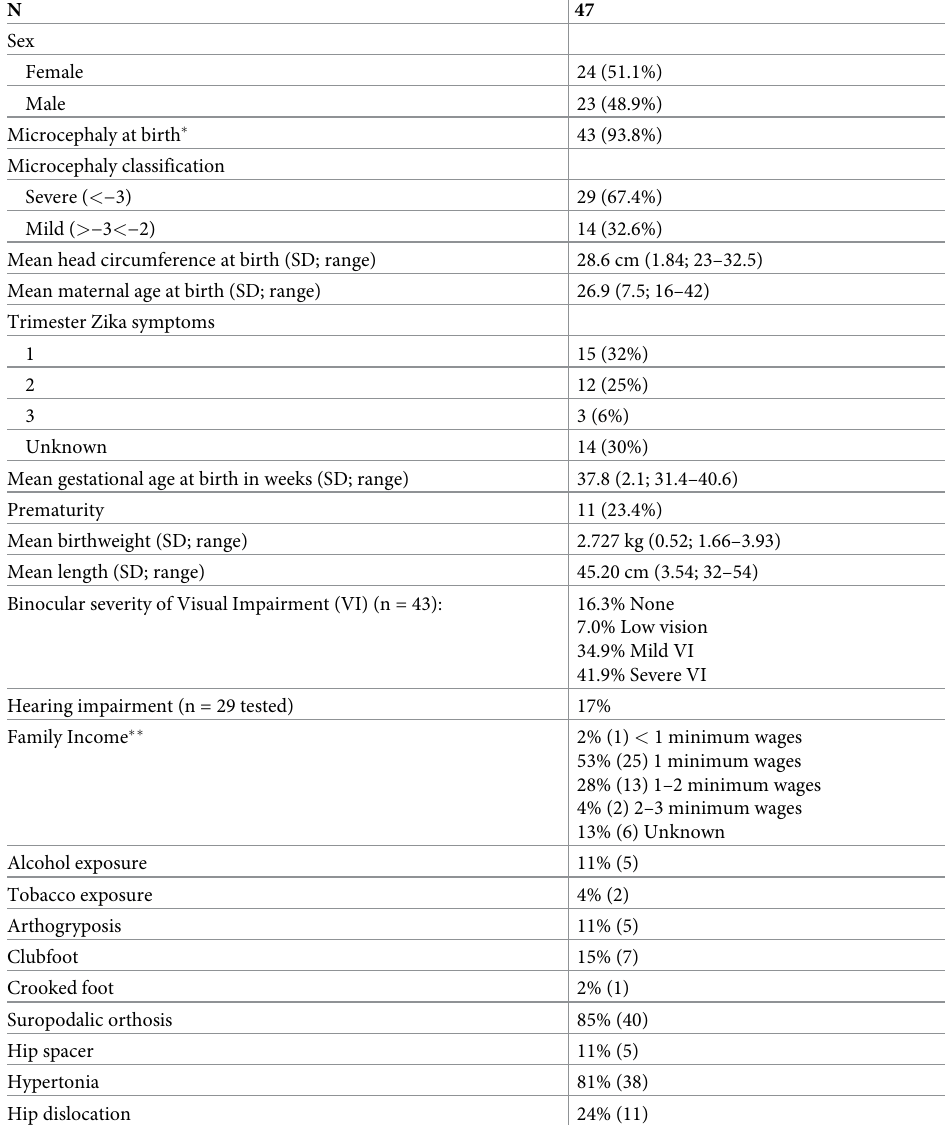
Table 1. Demographics of